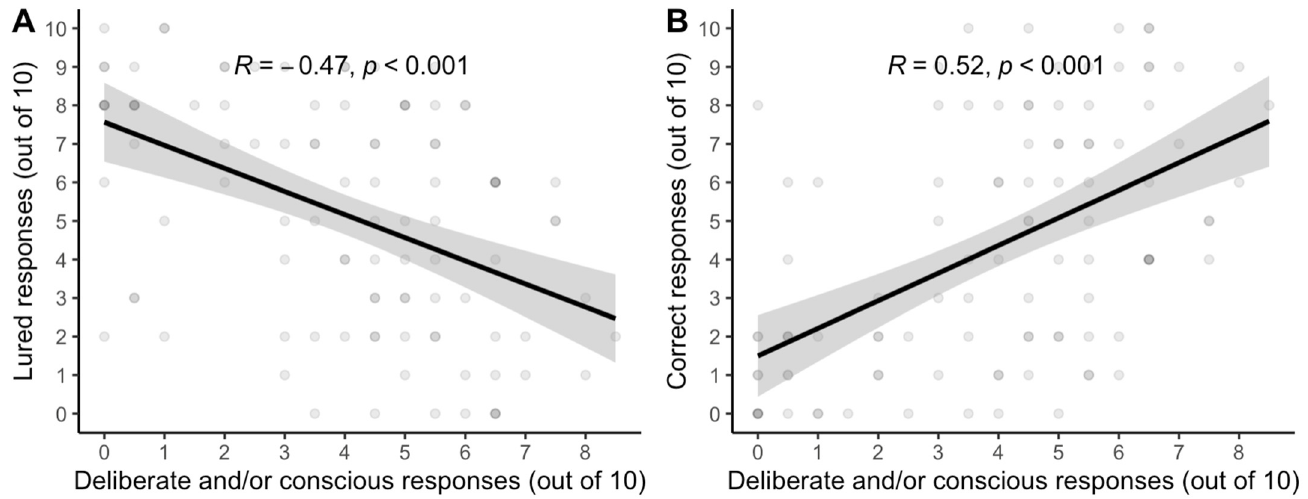
Figure 5. Correlations between the “two-factor” coding of reflective responses (deliberate and/or conscious) and ( A ) the number of lured—or so-called “unreflective”—responses and ( B ) the number of correct—or so-called “reflective”—responses on the verbal reflection test (vCRT) performance in Study 2 (N = 102). Gray bands represent a standard error.